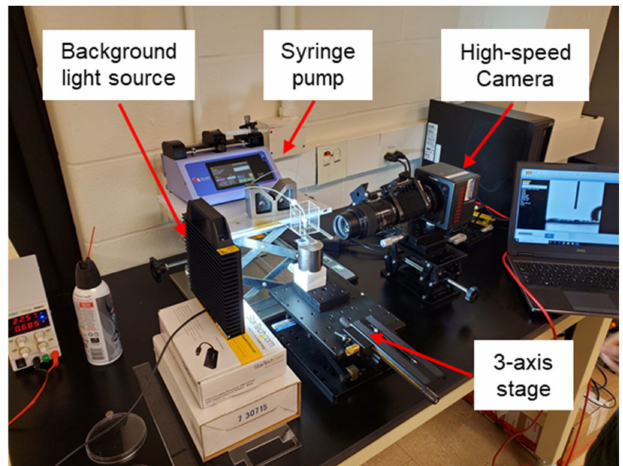
Figure 5. The test setup for capturing high-speed camera